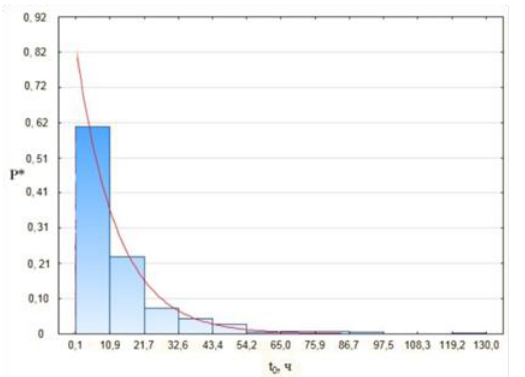
Figure 2. Histograms and distribution frequency functions of a time per fault of an electric part of rope shovels